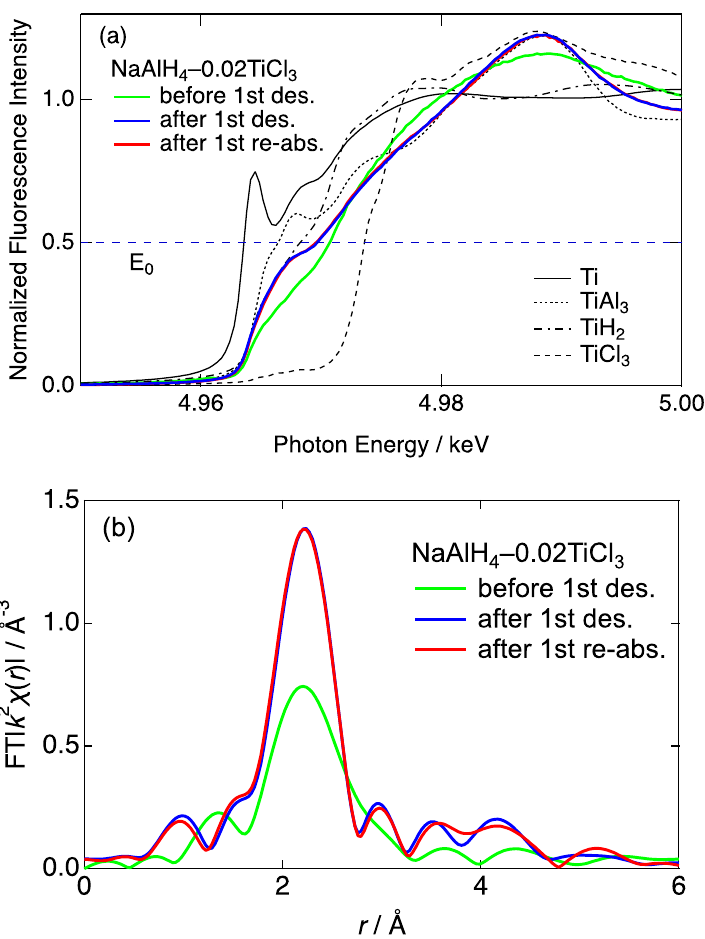
Figure 5. ( a ) XANES spectra and ( b ) radial distribution functions of NaAlH 4 –0.02TiCl 3 before the desorption, after the desorption, and after the re-absorption of hydrogen.